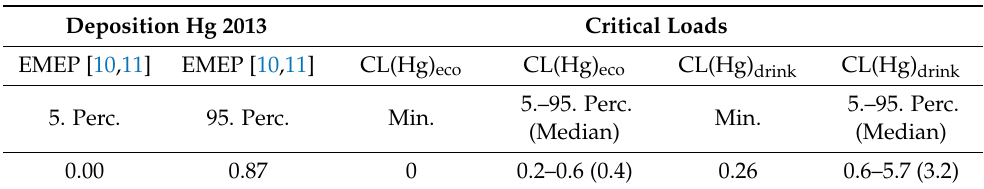
Table 6. Comparison of the Hg deposition (in g ha − 1 a − 1 ) in the year 2013 [10,11] with the critical loads (in g ha − 1 a − 1 ) of the receptor surfaces in